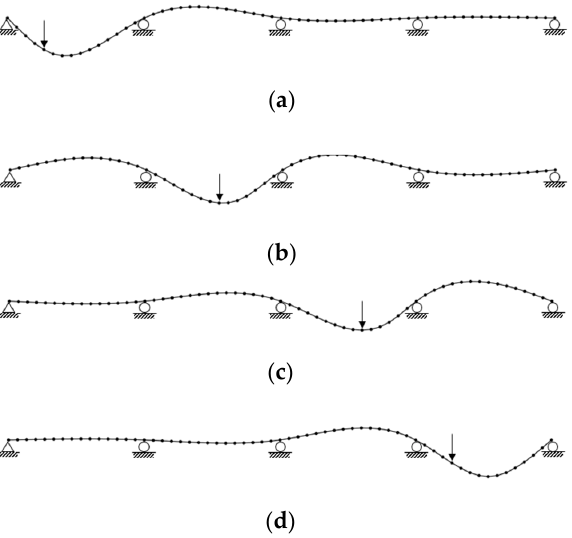
Figure 8. Examples of structural shape function (SSF) derived by static analysis (beam): ( a ) SSF4, ( b ) SSF22, ( c ) SSF37, ( d ) SSF46. Table 2. Sensor location in the FEM model used for estimation (beam). Measured Data